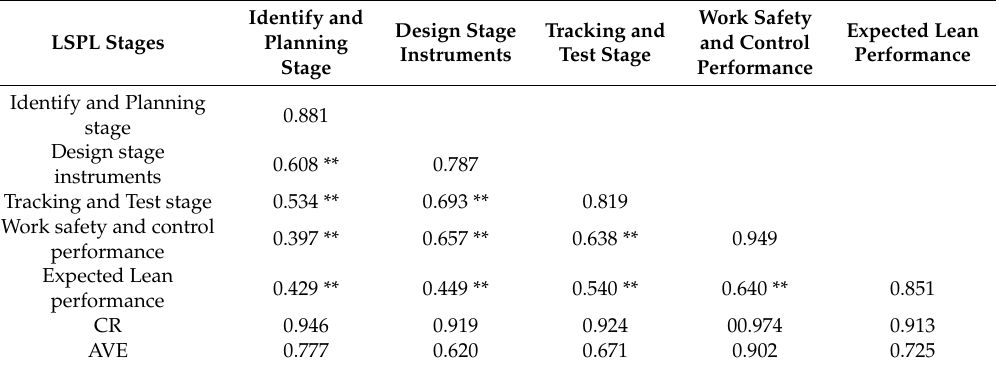
Table 17. Correlation matrix and average variance extracted